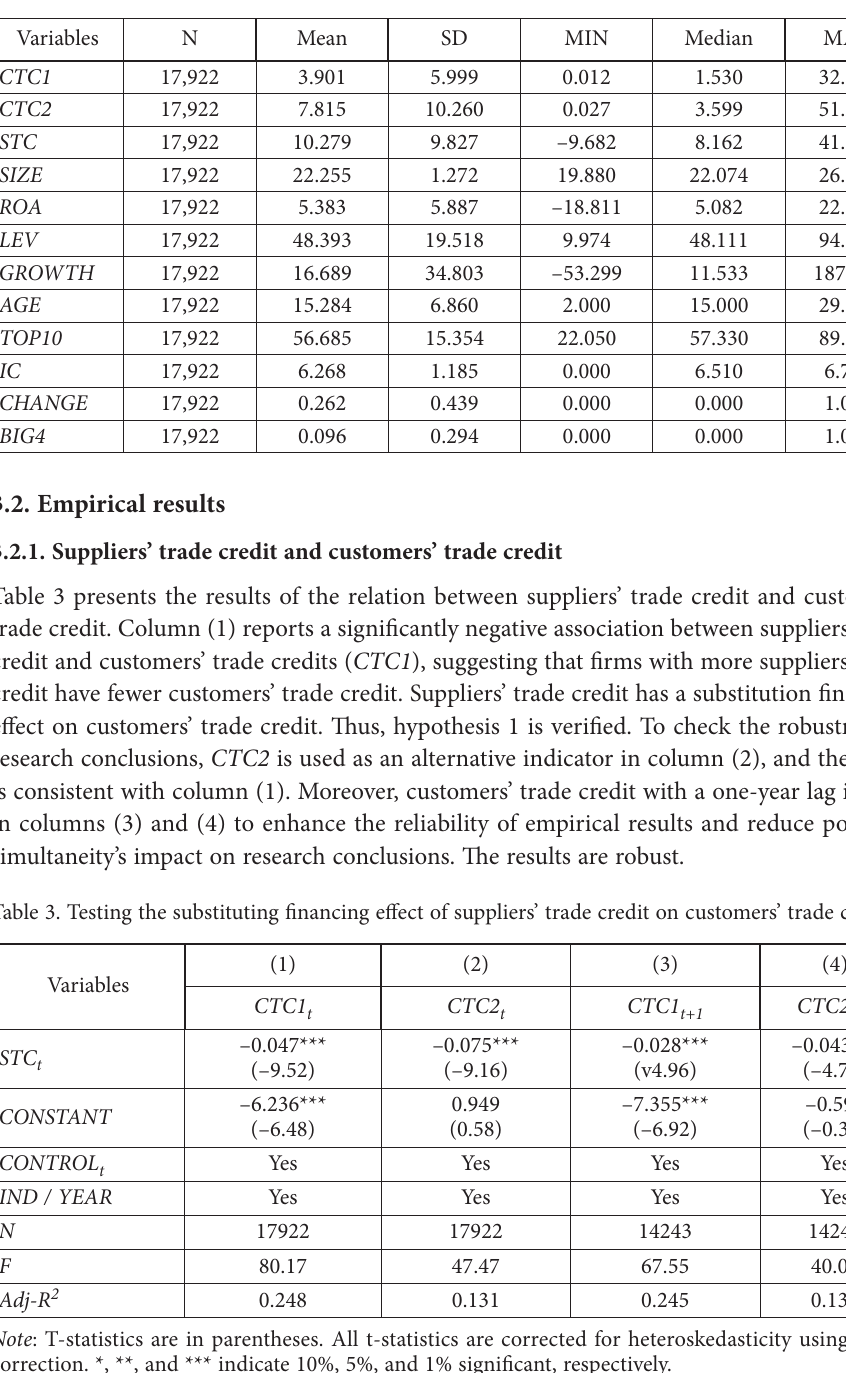
Table 2. Descriptive statistics for regression variables